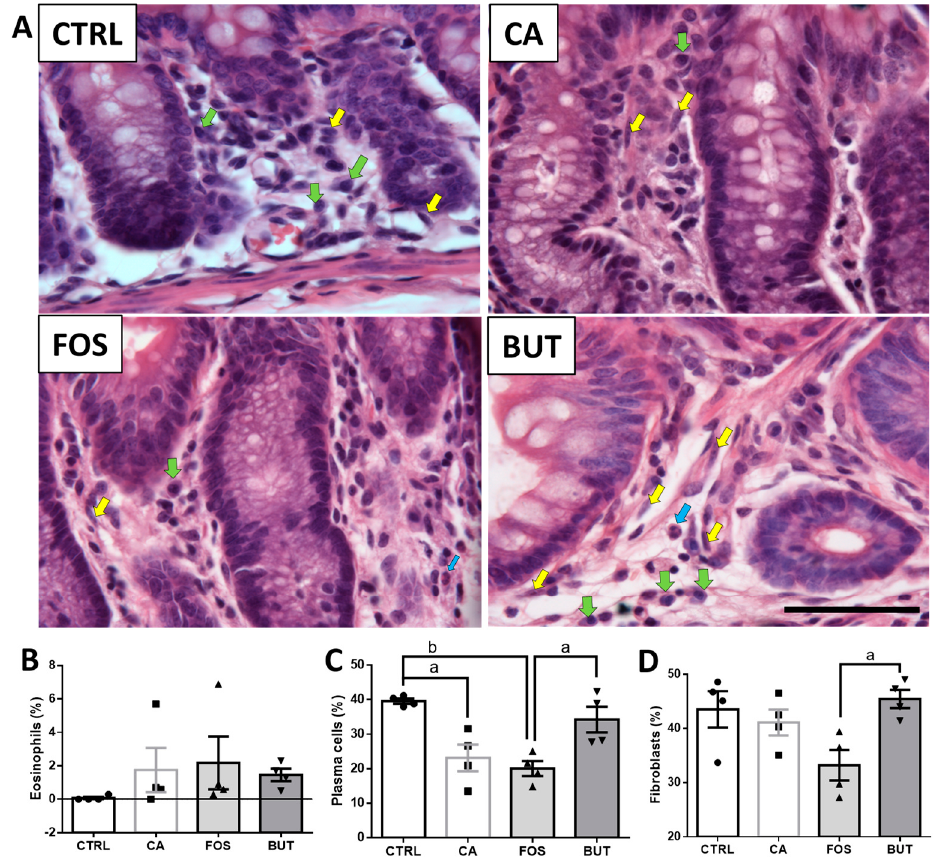
Figure 8. Cell infiltration in the lamina propria of the colon mucosa: Histological images of the colon ( A ) percentage of eosinophils (blue arrows, ( B )), plasma cells (green arrows, ( C )), and fibroblasts (yellow arrows, ( D )) in all lamina propria cells. The tissues were subjected to H&E staining; the images represent 100 × magnification; magnification bar: 50 µ m. Mice were divided into four groups: control group (CTRL— n = 5) fed with chow diet; and colon carcinogenesis-induced groups fed either with chow diet (CA— n = 5), TB-supplemented diet (BUT— n = 5), or with FOS-supplemented diet (FOS— n = 5). Colon carcinogenesis was induced chemically by azoxymethane (AOM)/dextran sodium sulphate (DSS). Data are presented as means ± SEM. The groups were compared using one-way ANOVA followed by Bonferroni post hoc tests; for p < 0.05 (a), p < 0.01 (b); black circles ( ● ), square ( ∎ ), triangles ( ▲ ), inverted triangles ( ▼ ) represents sample numbers in the corresponding group.